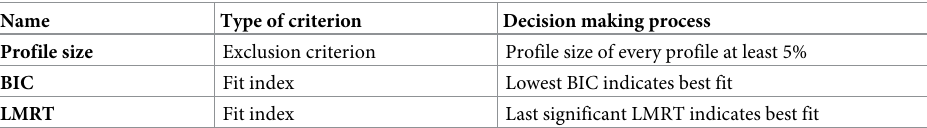
Table 2. Criteria for model